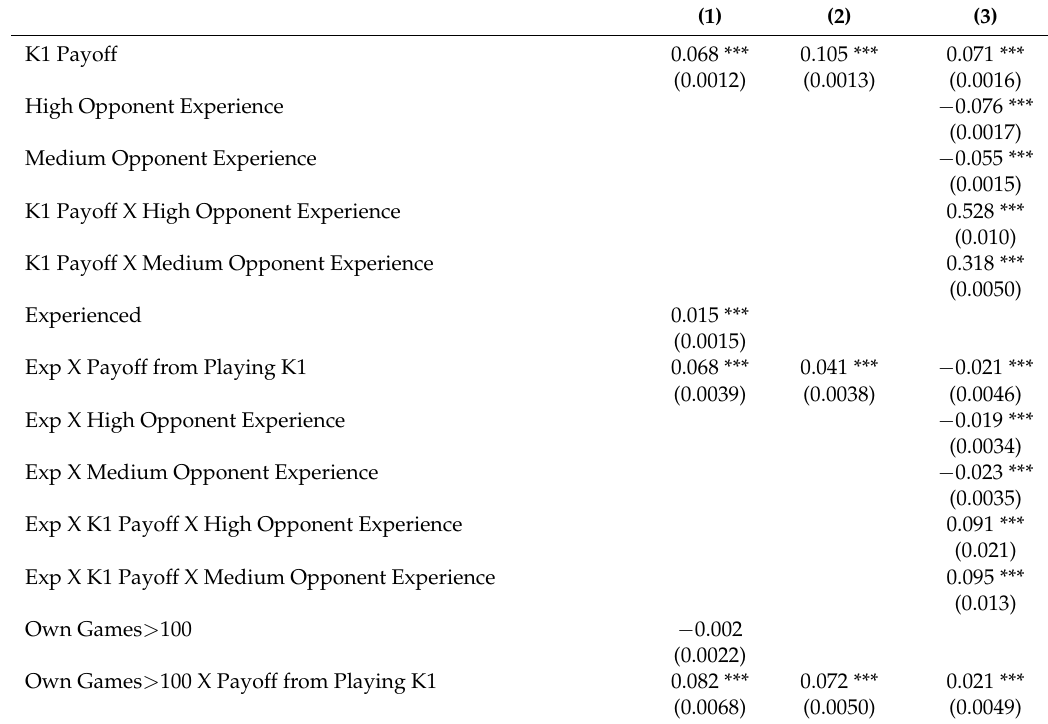
Table 12. Effect of Expected k 1 Payoff on k 1 -Consistency